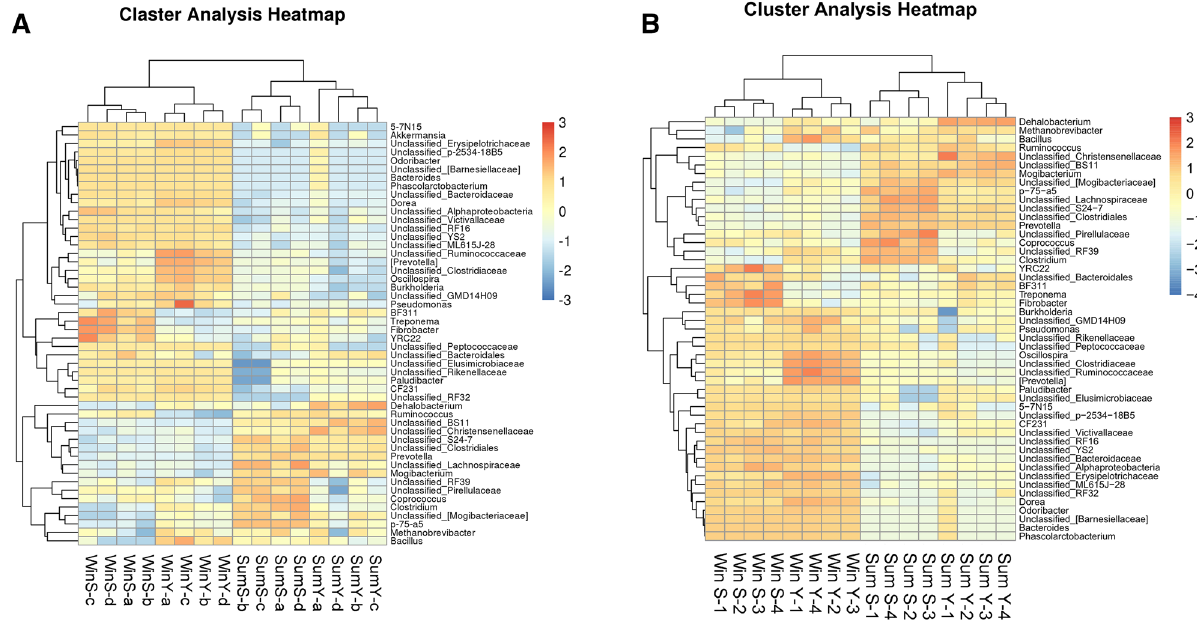
Figure 2. Cluster analysis heatmap of 16 samples randomly selected four from every group ( A ) and 16 sample of averages ( B ). The closer the color is to orange, the more relevant it is. The closer the color is to blue, the less relevant it